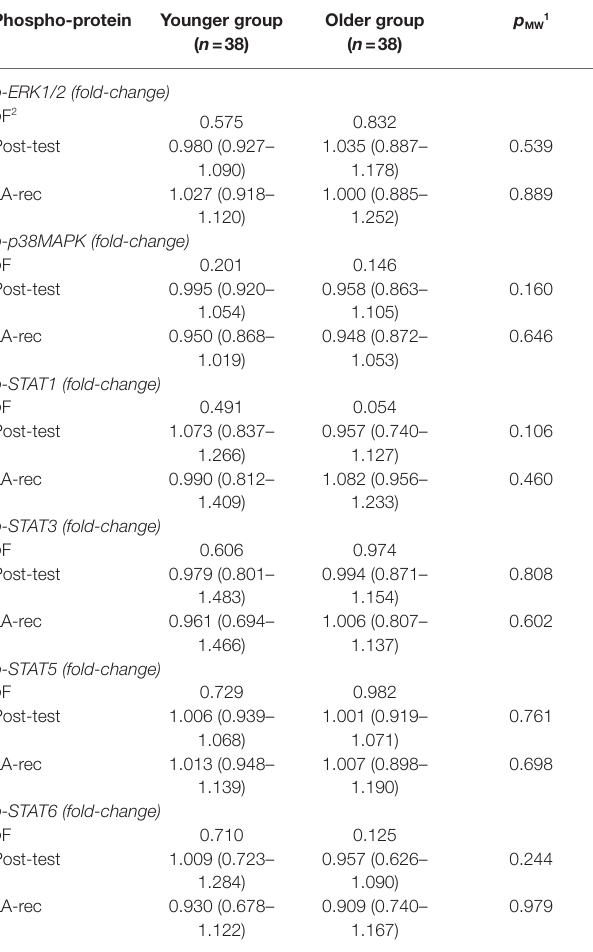
TABLE 6 | The changes in calculated values of median fluorescence intensity (MFI) measuring phosphorylation level of analyzed proteins